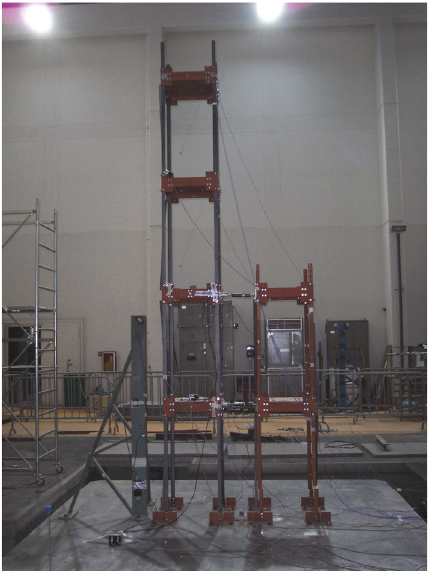
Figure 1: Tridimensional physical model mounted on the shaking table with MR damper at the second